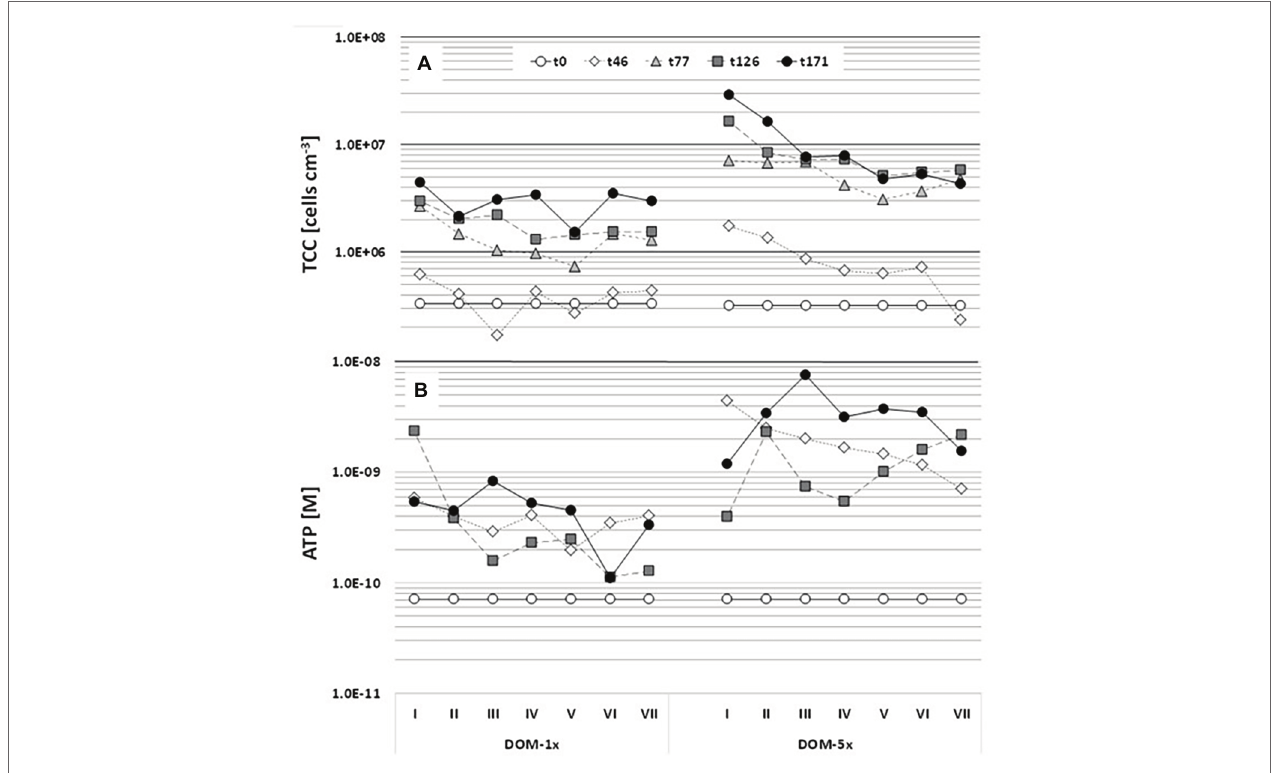
FIGURE 5 | Dynamics of sediment bacterial biomass (A) and activity (B) over 171 days of incubation. The microcosms were infiltrated by the DOM-1x and DOM- 5x feeding solution from left to right, entering the microcosms at sector I and leaving at sector VII. Samples were collected from the top sediment layer of each microcosm. Values are means of duplicate measurements of technical replicates.